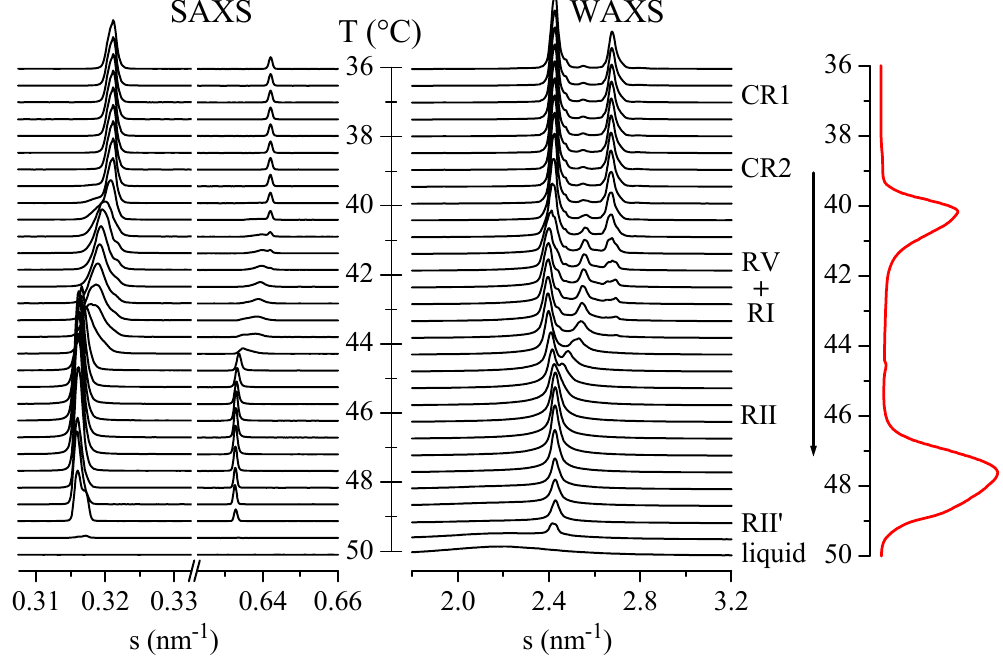
Figure 3. Small-angle X-ray scattering (SAXS)/wide-angle (WA)-XS diffractograms for sample C 23 H 48 in a heating experiment at 2 °C/min. The corresponding DSC heating curve is also shown at the right. For clarity of the presentation, only one out of every five diffractograms is plotted.